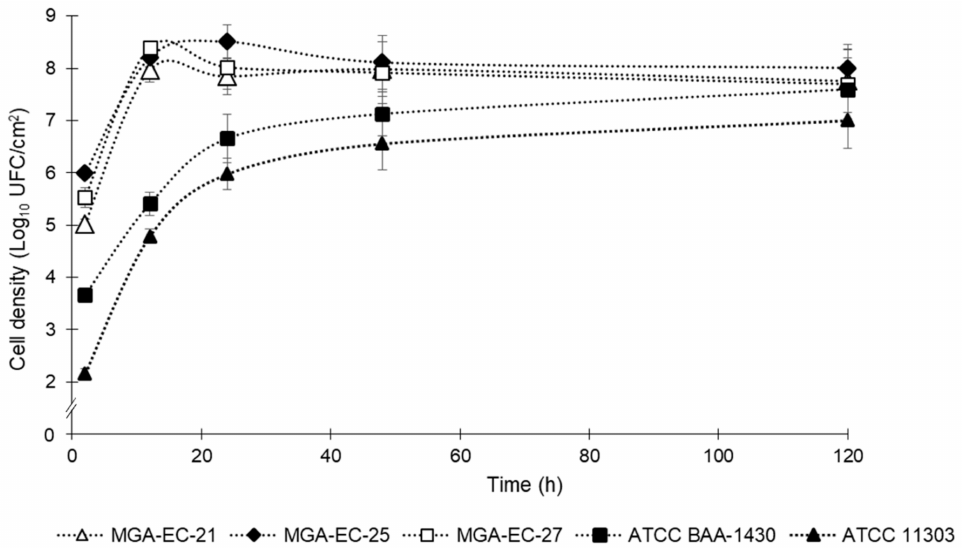
Figure 1. Biofilm development curve for SS coupons of the strains MGA-EC-21, MGA-EC-25, MGA- EC-27, E. coli ATCC BAA-1430, and E. coli ATCC 11303, at 2, 12, 24, 48, and 120 hours. Values are the means of three tests and vertical bars represent the standard